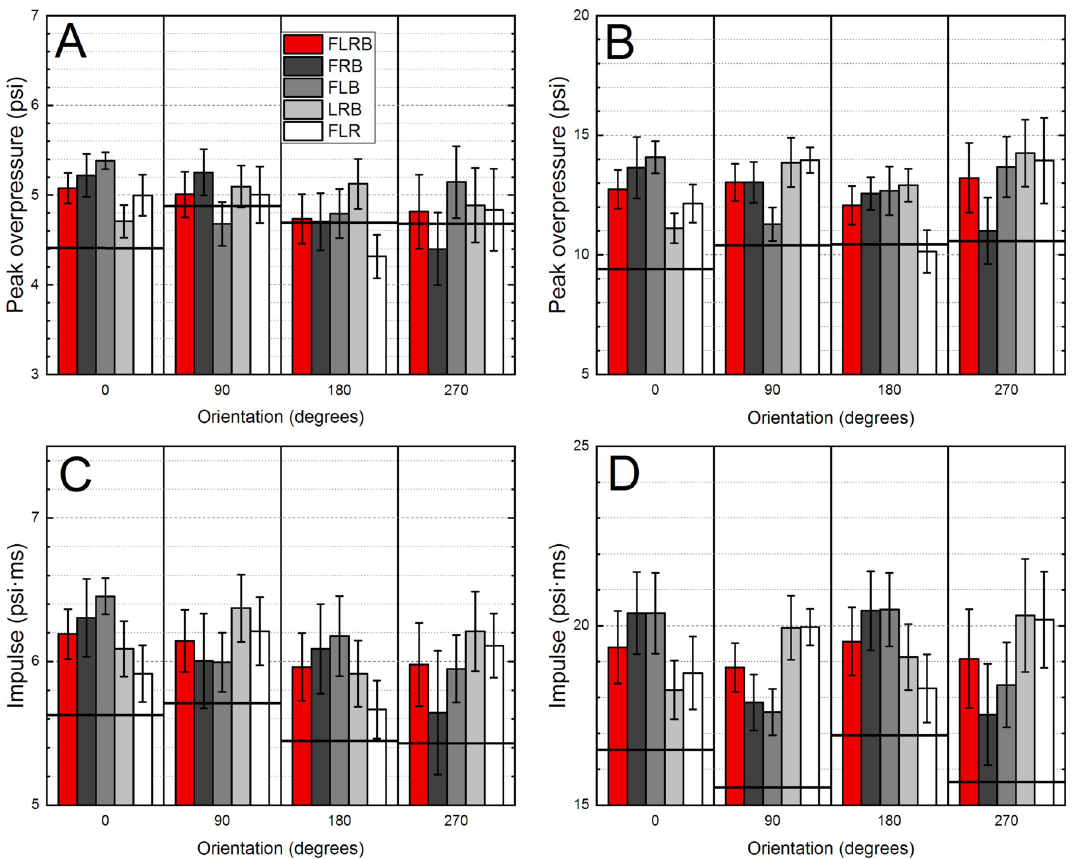
Fig 5. The results of the quantification of the averaging of the 3 sensor readings, the peak overpressure (A, B) or impulse (C, D) recorded by the B3 Blast Gauge mounted on the ACH helmet. The average of four sensors (labelled as FRLB) was compared against various combinations of 3 sensor averages (labelled as: FRB, FLB, LRB and FLR). The results as a function of helmet orientation for the data collected at 5 psi (A, C) and 10 psi (B, D) are presented. The horizontal black line indicates the incident peak overpressure (or impulse) calculated as an average of two sensors: LEFT and RIGHT for 0˚ and 180˚, or FRONT and BACK for 90˚ and 270˚ ACH orientations, respectively.